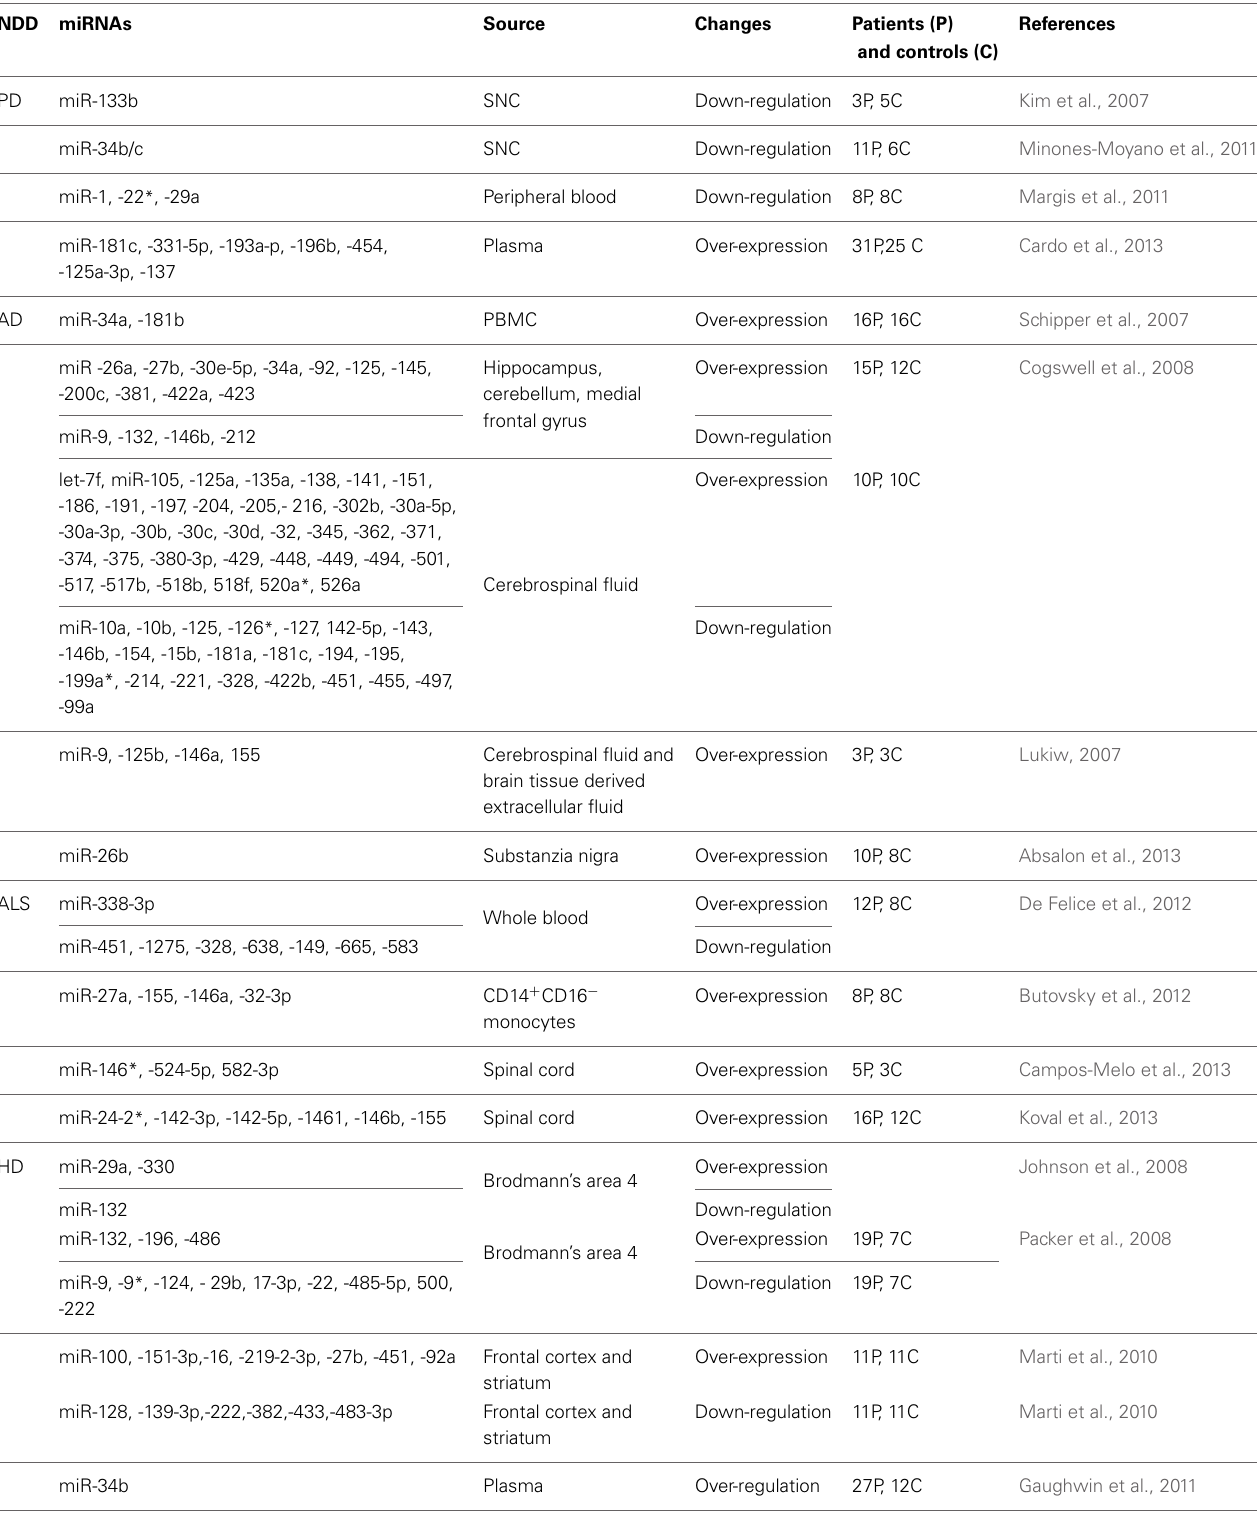
Table 2 | miRNAs deregulation in NDDs